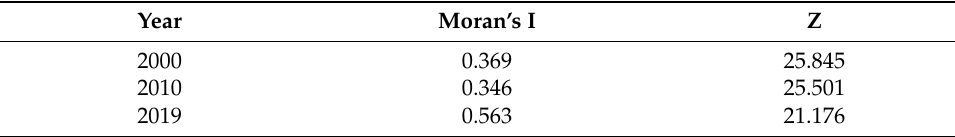
Table 1. Moran’s I for the NGPR.